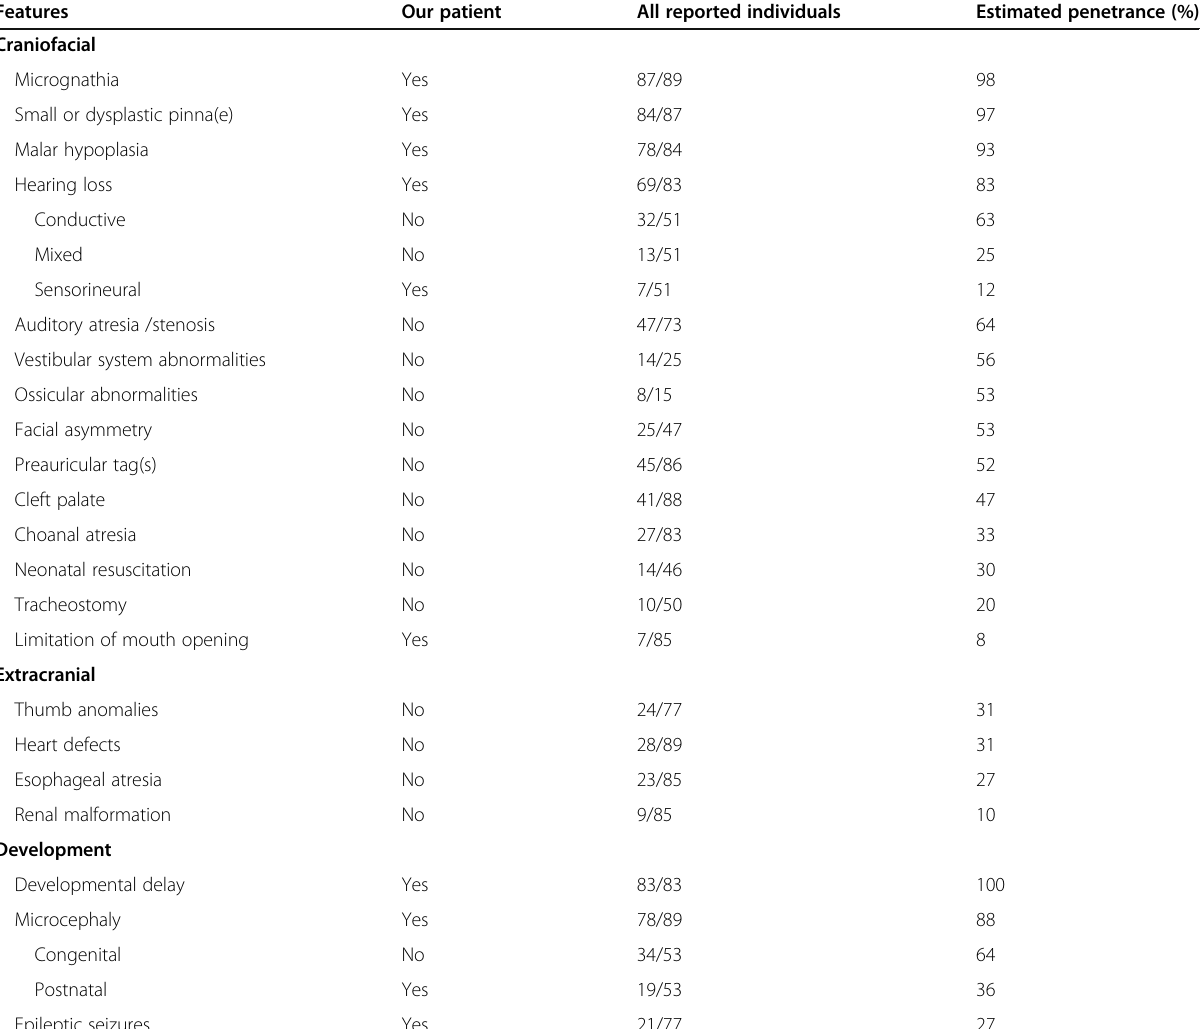
Table 1 Detailed clinical features of our patient compared to the spectrum of clinical symptoms observed in patients with MFDM